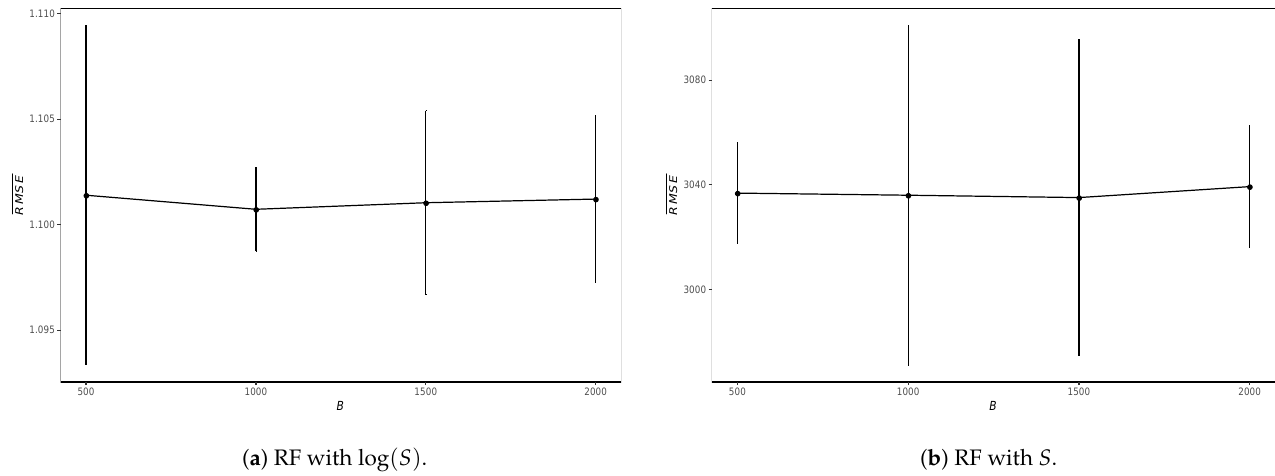
Figure 7. Illustration of the RMSE model error and 95%-confidence intervals along the number of trees B for both RF log S and RF S